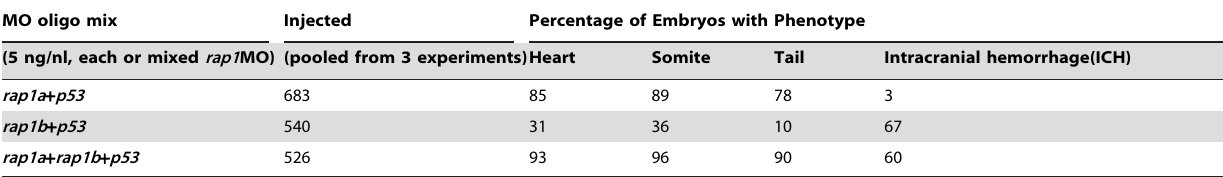
Table 1. Phenotype summary of the rap1 MO fish.